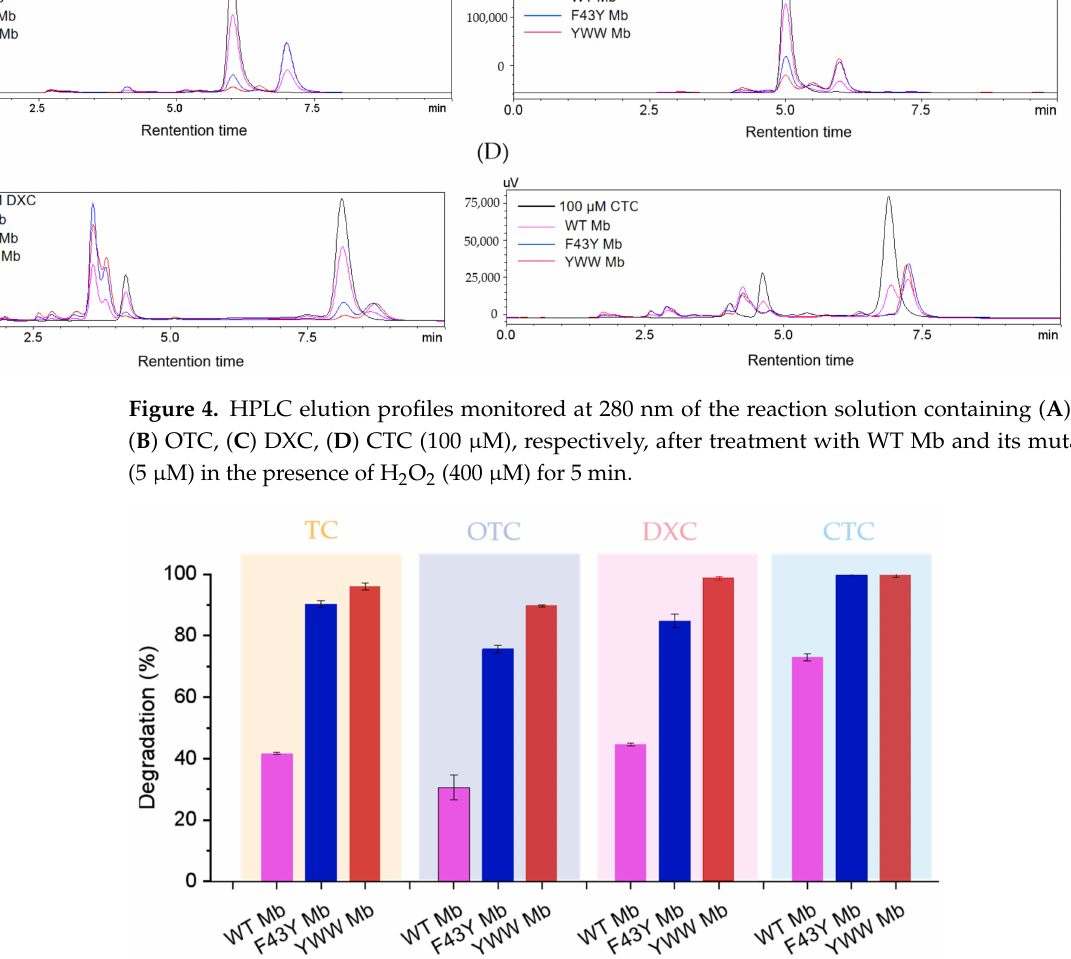
Figure 5. Degradation rates of antibiotics catalyzed by Mb and its mutants. Reaction conditions: 5 µ M protein, 400 µ M H 2 O 2 , 100 µ M antibiotics, 50 mM potassium phosphate buffer at pH 7.0, reaction for 5 min. The error bars represent the standard deviation of the